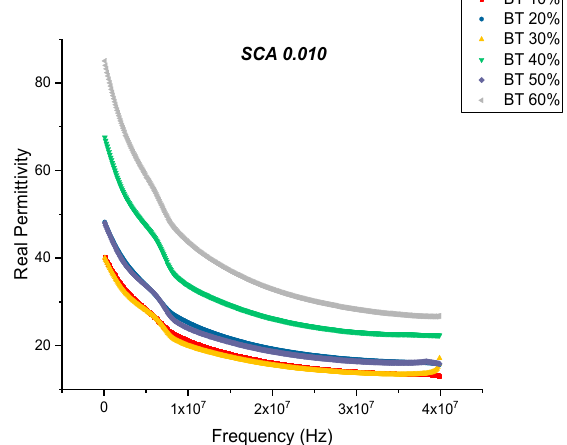
Figure 6. The real permittivity of the BaTiO 3 -epoxy composite that were fabricated using BaTiO 3 nanoparticles which were surface modified using 0.010 SCA is plotted as a function of frequency where the volume fraction of BaTiO 3 is varied from 0.1 to 0.6.